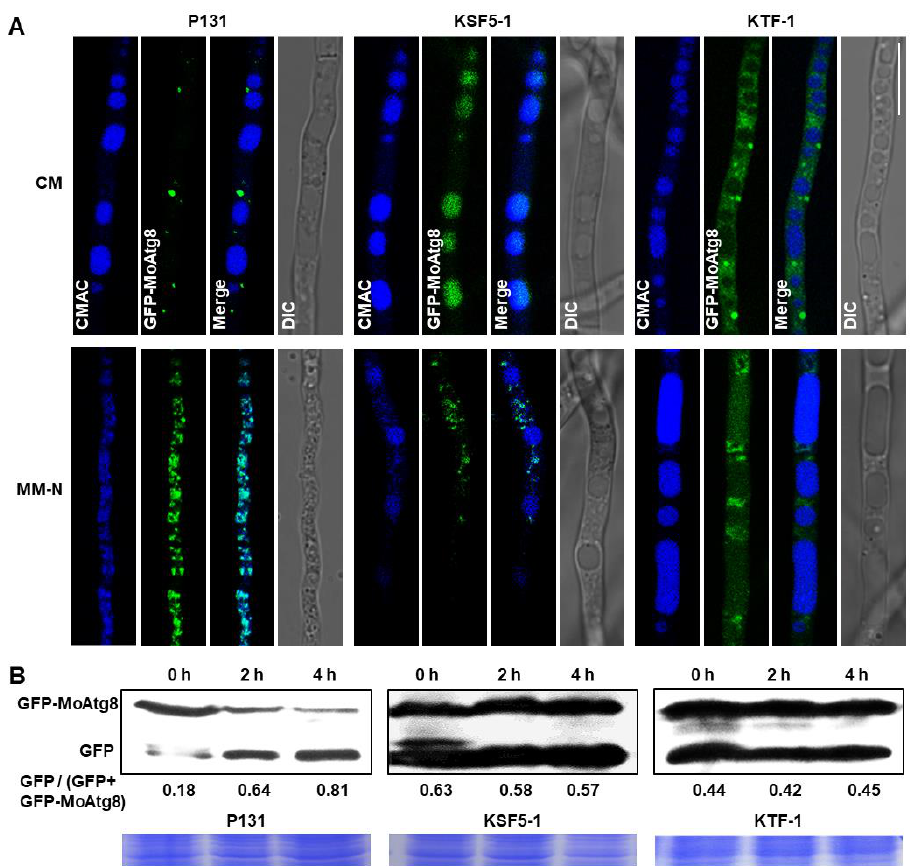
Figure 8. Both MoSnf5 and MoTaf14 are involved in autophagy. ( A ) Subcellular localization of the GFP-MoAtg8 fusion in the wild-type P131, the Δ Mosnf5 mutant KSF5−1 , and the Δ MoTaf14 mutant KTF−1 . The strains were first grown in liquid CM medium for 48 h (upper panel), and then shifted to a nitrogen starvation condition (liquid MM-N medium with 4 mM PMSF) for 4 h (lower panel). Mycelia were stained with CMAC and examined under a fluorescence microscope . Bar, 10 μm. ( B ) The proteolysis of GFP-MoAtg8 in strains P131, KSF5−1 , and KTF−1 . Mycelia were cultured in liquid CM medium for 48 h (0 h), and then the autophagy was induced under nitrogen starvation condi- tions for 2 h (2 h) and 4 h (4 h). Mycelia were collected at the indicated time and analyzed by Western blot with an anti-GFP antibody.